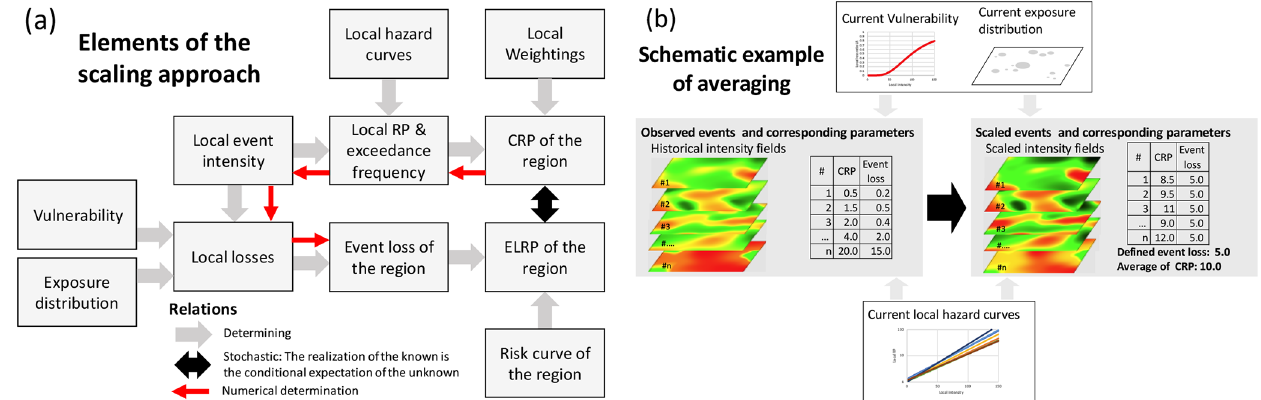
Figure 4. Schemes of the scaling approach: (a) elements and relations, (b) schematic example for estimation of RP of event loss by averaging of